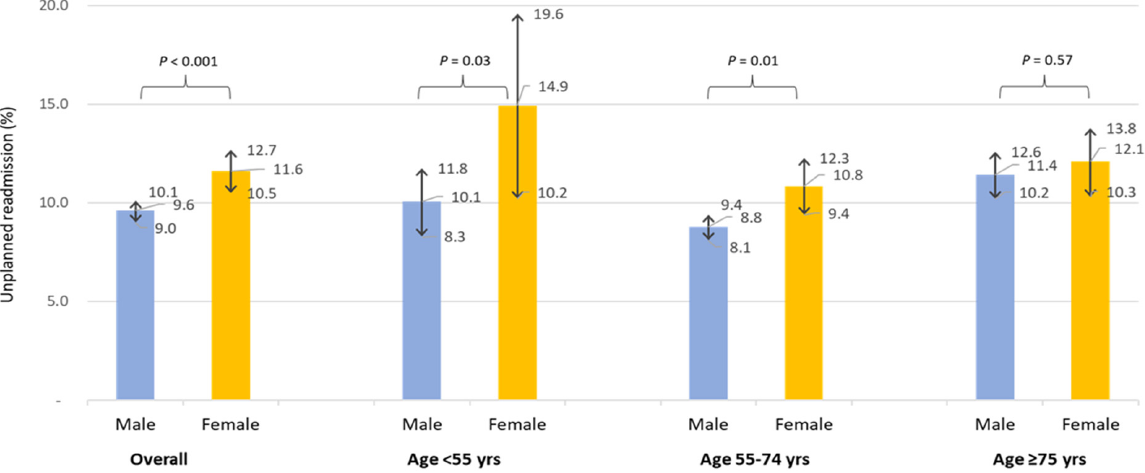
Figure 1. Unplanned cardiac readmission (first instance) and corresponding 95% confidence interval within first year following procedure by sex and age.